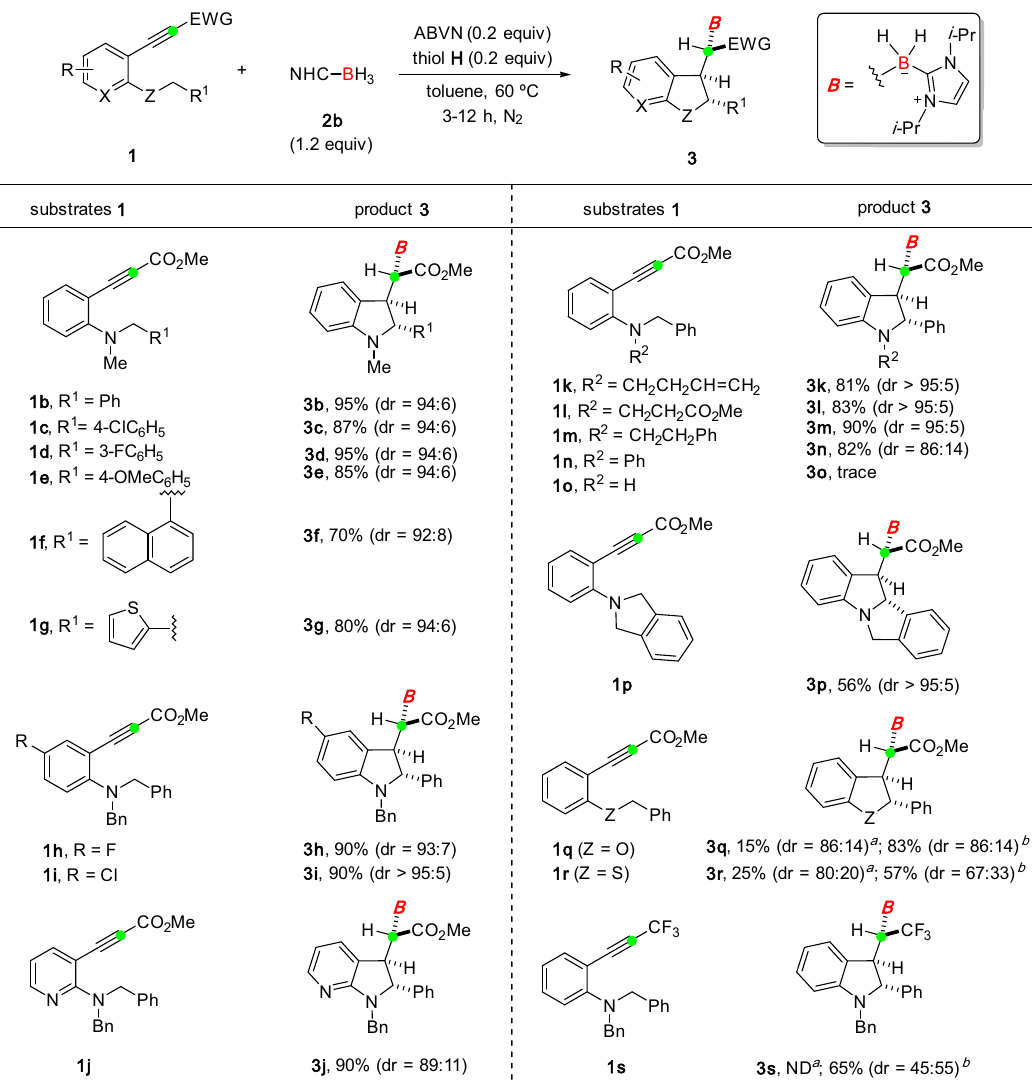
Fig. 2 NHC-BH 3 /thiol catalyst-controlled stereoselective synthesis of borylated molecules derived from RATC. Reactions were performed with substrate 1 (0.2 – 0.5 mmol), 2b (1.2 equiv), ABVN (0.2 equiv), and thiol H (0.2 equiv) in toluene (2 – 3 mL) at 60 °C for 3 – 12 h. The yield is recorded for the combination of diastereomers 3 and 4 . dr refers to the ratio of 3 : 4 . ND, not detected. a Results obtained with the reaction conducted under standard reaction conditions and a competing hydroboration reaction of the alkyne moiety was observed. b Results obtained with the reaction conducted using 2a (1.2 equiv) and ACCN (0.5 equiv) at 95